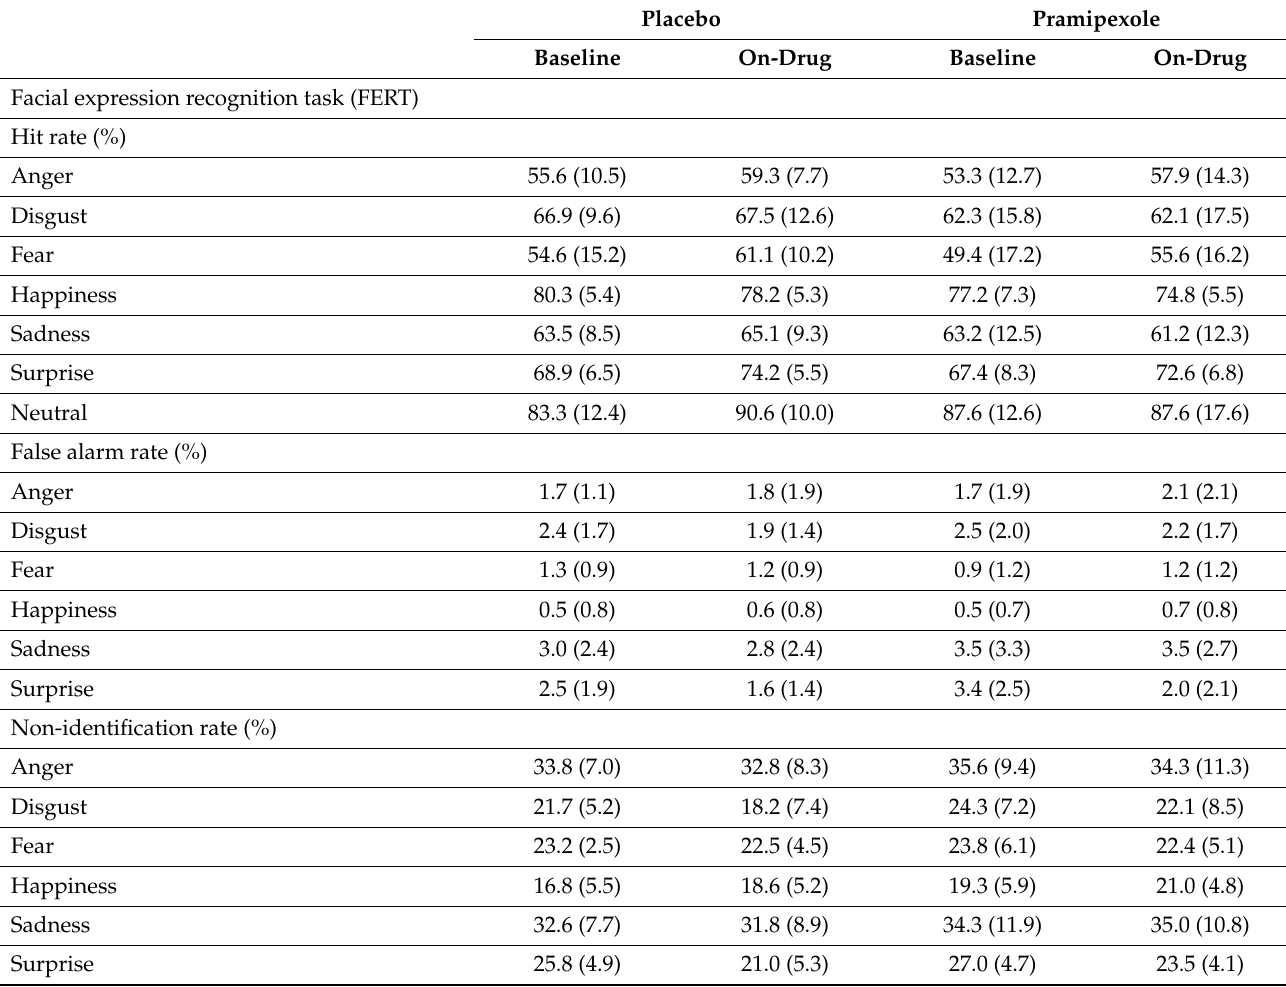
Table 4. Behavioural measures of emotional processing at baseline and on-drug. Values represent means with standard deviations in parentheses. Placebo Pramipexole Baseline On-Drug Baseline